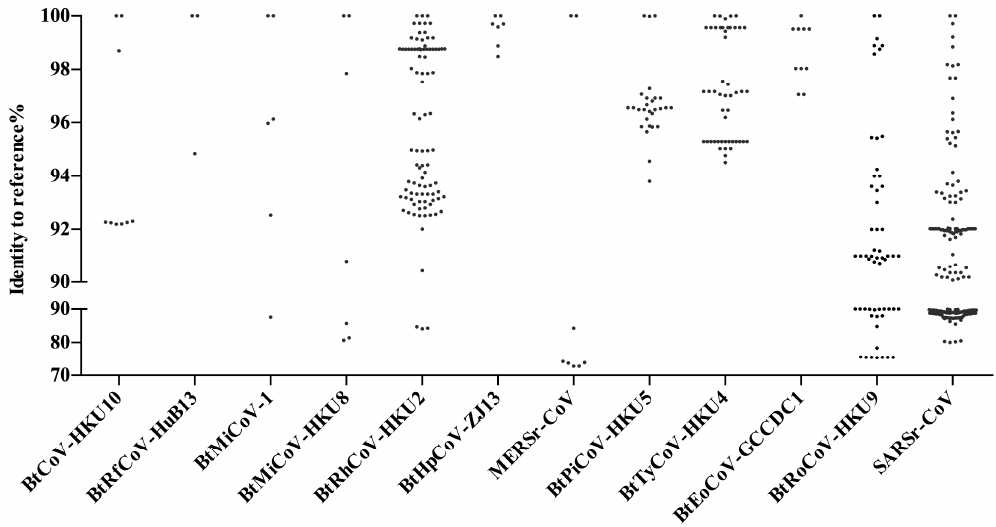
Figure 2. Genetic diversity of bat CoV in China. Sequences of 440 bp conserved the viral polymerase (RdRp) region for each CoV species were compared to related reference sequences. Reference